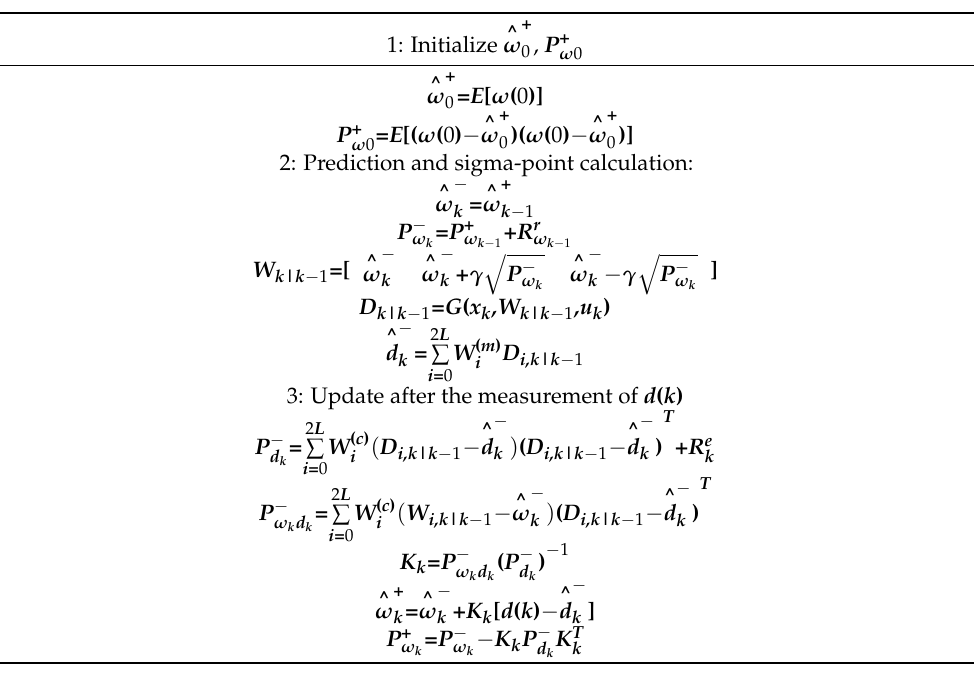
Table 4. UKF for VDPs